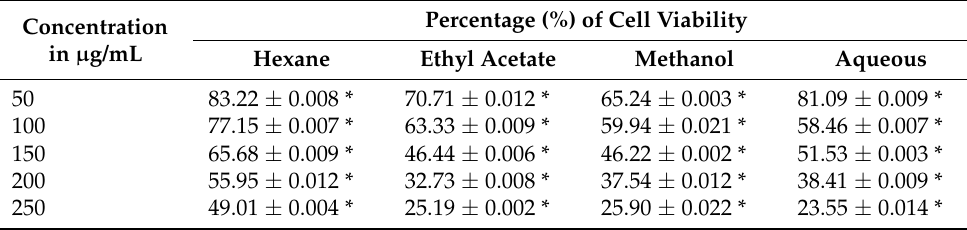
Percentage (%) of Cell Viability